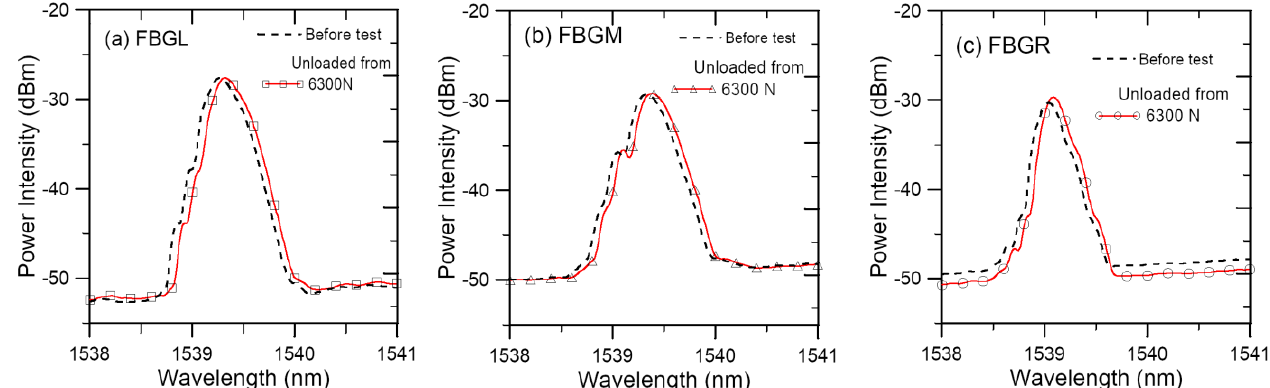
8 of 22 Figure 3. FBG spectra at various loadings in a typical tensile specimen. To isolate any contribution of joint damages from that of applied load on the spectral shapes, load-free FBG spectra were measured on unloading after progressively loading up and are shown in Figure 4. Only the initial spectra and the last spectra measured before tensile failure are shown for clarity. The intermediate spectra during the course of loading lay between these two extremes and changed very little. In each of the spectra from the three FBGs, a slight shift to the longer wavelength is evident. However, the shape of the waveforms remained nearly unchanged. This trend was observed in 21 out of 24 FBGs. In these FBGs, not only the fully unloaded spectra but also the spectra measured on unload- ing to 400 N exhibited the same phenomena. Of the remaining three FBGs, one showed a